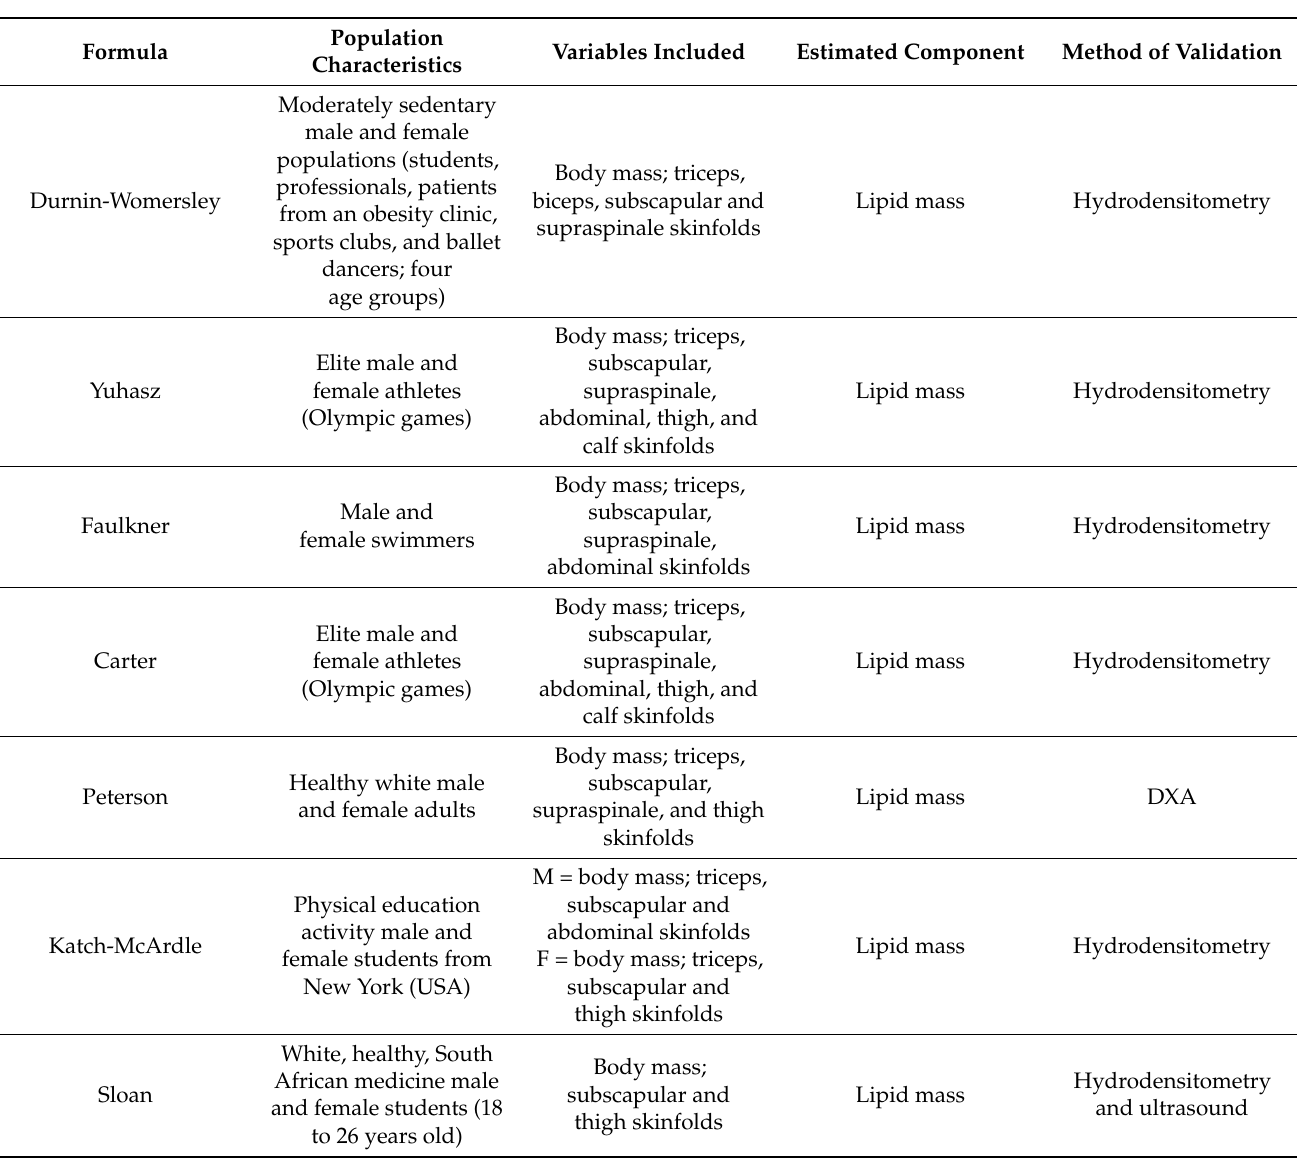
Table 1. Characteristics and information regarding the validation, variables and estimated component of the formulas